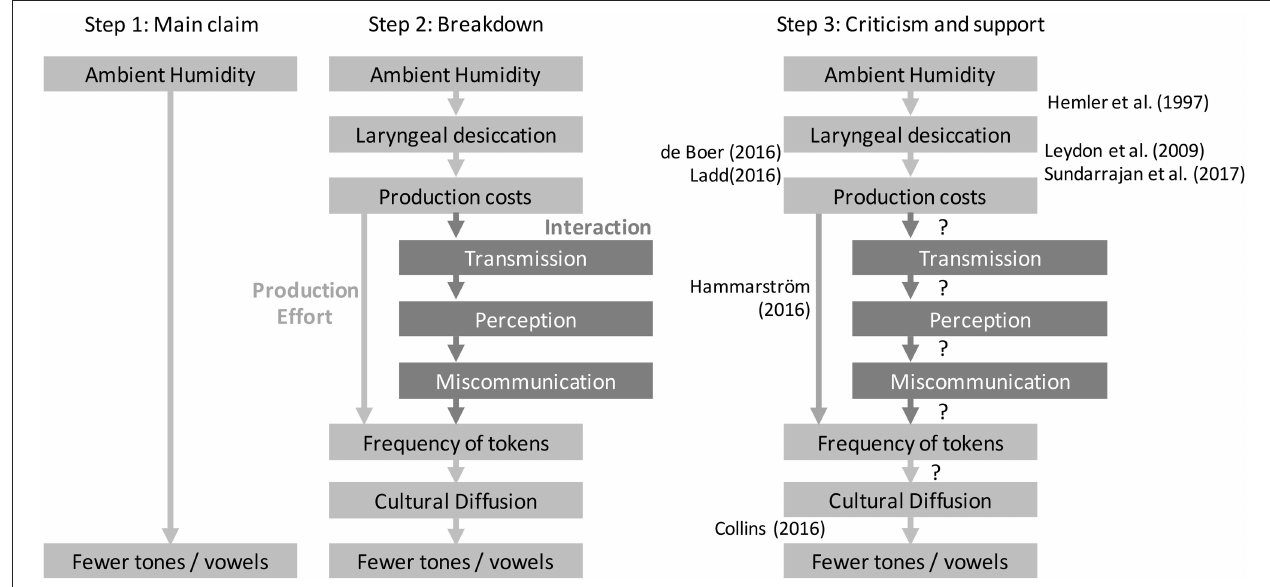
FIGURE 1 | The first three steps in the causal approach. Left: Step 1, starting with the main causal claim. Middle: Step 2, breaking the main claim down into a chain of links. Right: Step 3, assessing criticism and support. Criticisms are listed on the left and supporting evidence is listed on the right. Question marks represent no supporting evidence for the particular link.